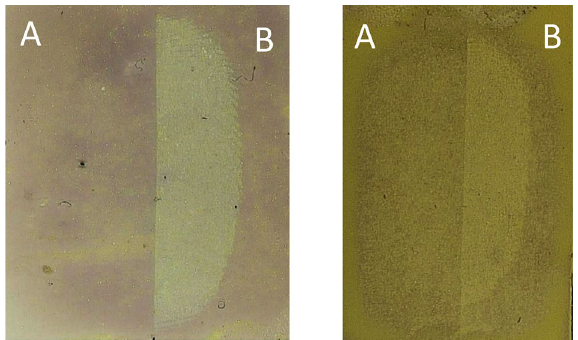
Figure 2. Fingermark development using RECOVER system on gelatin lifter. Fingermark deposited on paper substrate, with solid black ink printed over half of the fingermark ( A ) and the other half left uncovered ( B ). The gel on the left was lifted immediately after ink printing. The gel on the right was lifted 72 h after ink printing.